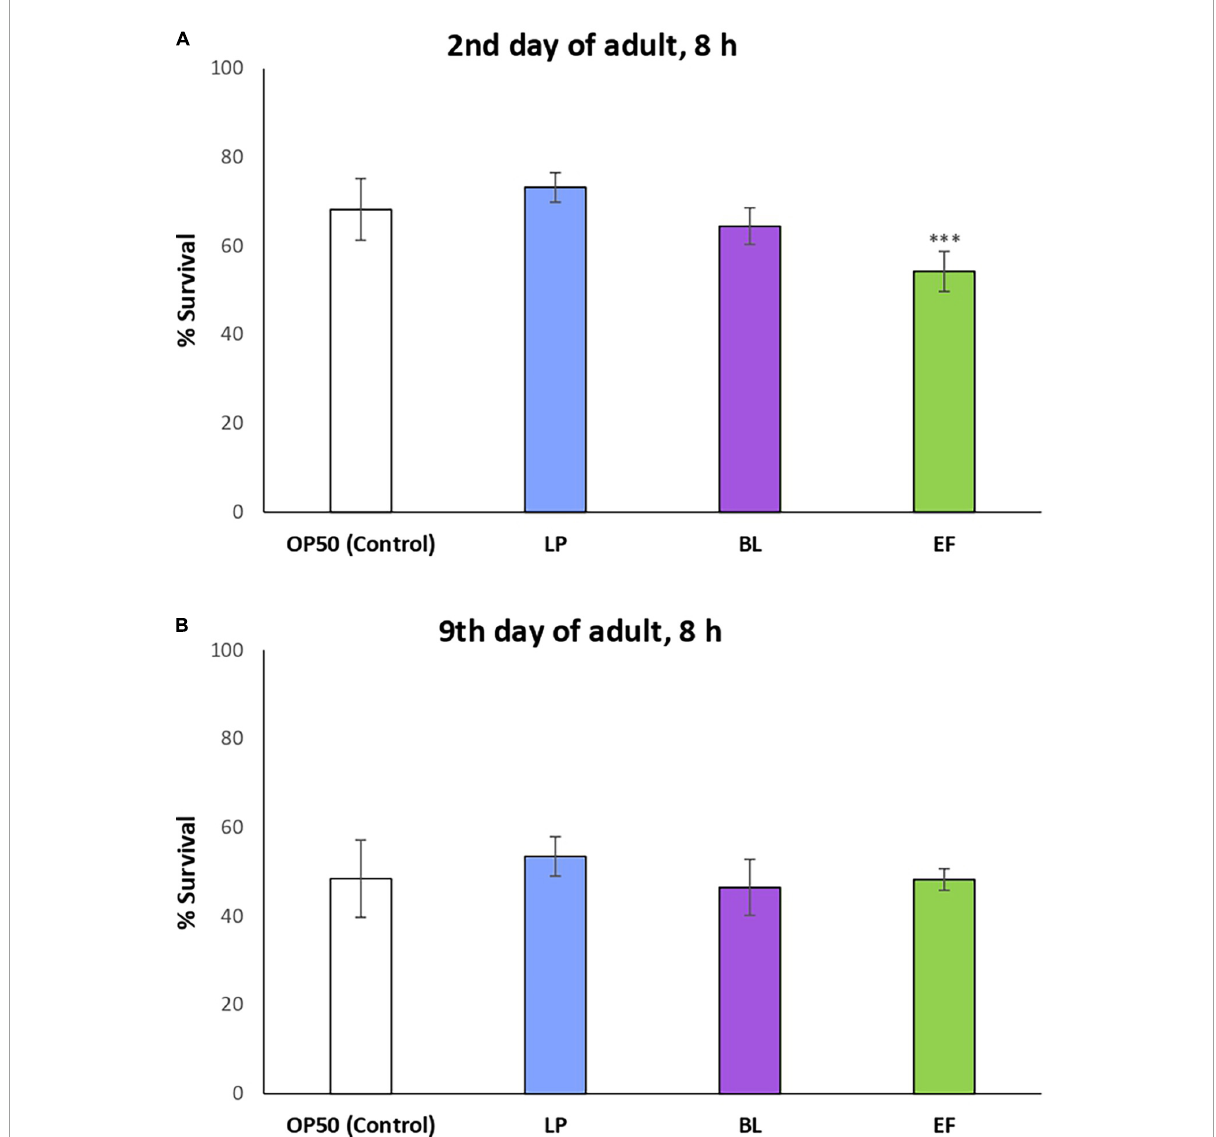
FIGURE3 Percentages of survival following thermal stress (35 ◦ C, 8 h) applied at days 2 (A) and 9 of adulthood (B) in N2 wild type C. elegans grown in presence of different bacteria strains: Lactobacillus plantarum CLC17 (LP), Bifidobacterium longum NCIMB 8809 (BL), Enterococcus faecium CECT 410 (EF) and E. coli OP50 (control). Statistical significance was calculated using the Chi-Square Test. The differences were considered significant at *** p <